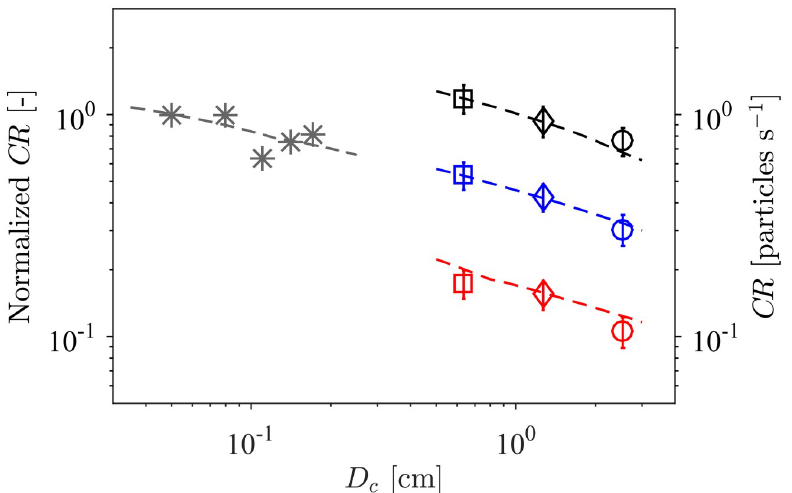
Fig 8. The observed decrease in contact rate with collector diameter. Coloured symbols represent experimental measurements of capture rate (on the right-hand axis) for rigid collectors at U 1 = 0.6 cm s -1 (red), 1.0 cm s -1 (blue) and 1.8 cm s -1 (black) [14] (markers as per Table 2). Gray asterisks ( � ) represent experimental measurements of normalized capture rate (on the left-hand axis) of bivalve spat by filamentous branched structures [13]; that is, the rate of contact with a collector of given diameter relative to that with the smallest collector employed. The broken lines indicate model estimates, which clearly support the reduction in particle contact with increasing collector size.